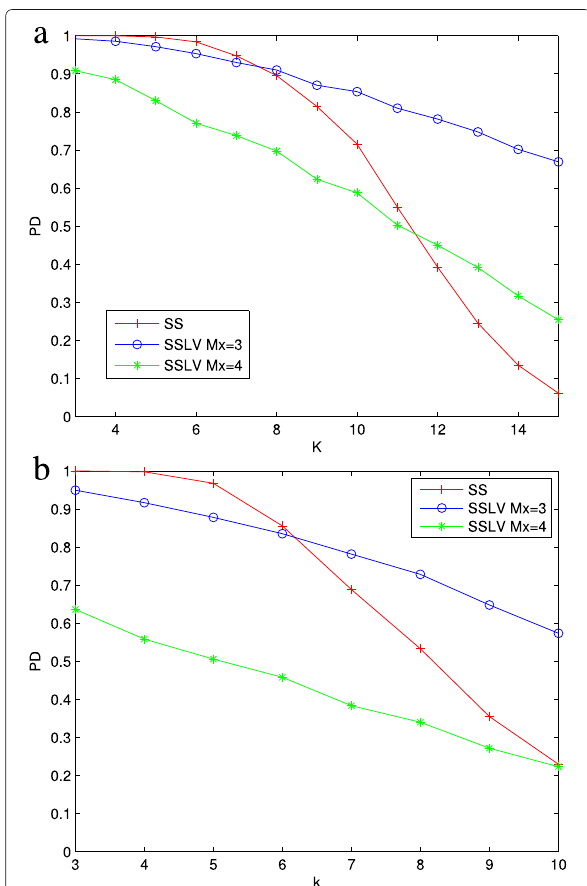
Fig. 4 Probability of false alarm for MA versus threshold k . Here, we have N (cid:2) = 27, b = 5, σ 2 =1, σ w 2 = 4, p fa = 0.05, and f ov = 5. Simulations are based on 5000 runs. a Grid deployment. b Random deployment